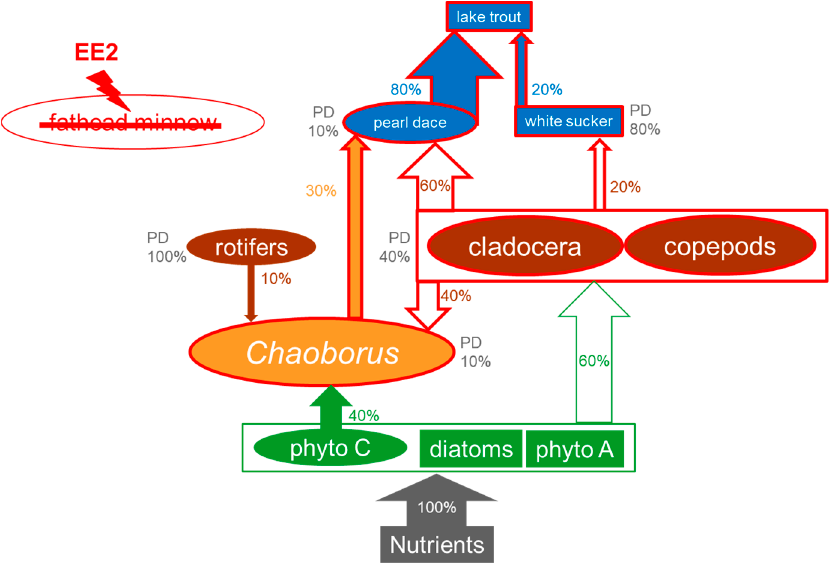
Figure 20. Dependence diagram of the studied freshwater food web after adding the collapse of Figure 2. The percentages represent the feeding preferences and the size of the different groups is proportional to the biomass changes due to EE2 addition (abbreviations: PD = particulate detritus; legend: filled arrows: transfer from one group, open arrows: transfer from multiple groups, highlighted in red: direct and indirect EE2 effects).